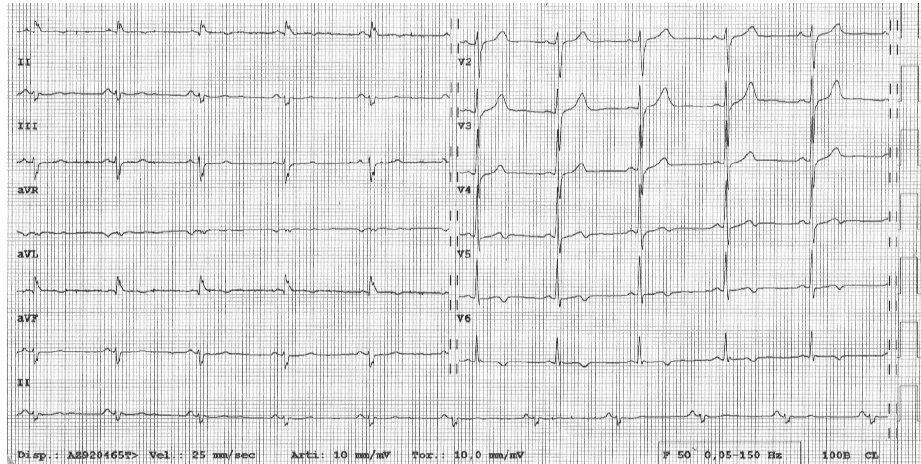
Figure 3. Electrocardiogram of patient with desmoplakin ( DSP )-related left dominant arrhythmogenic cardiomyopathy. Basal electrocardiogram showing T-wave inversion in lateral leads and low QRS voltages (<0.5 mV) in limb leads.